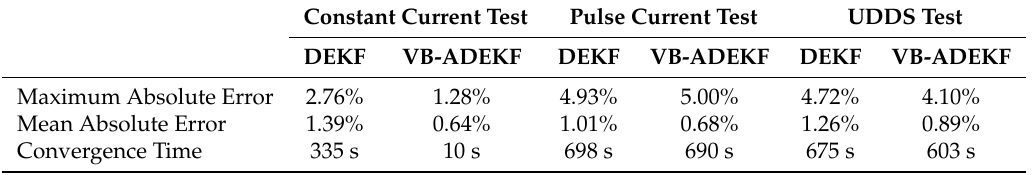
Table 2. Statistical analysis of state of charge (SOC) estimation error (after 12 min) in three